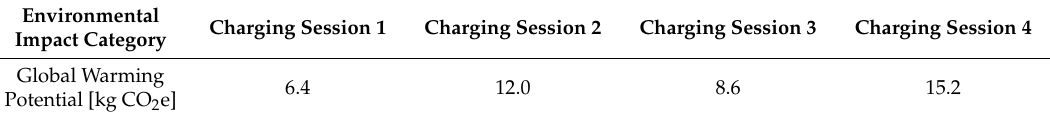
Table 2. GWP of the charging sessions.